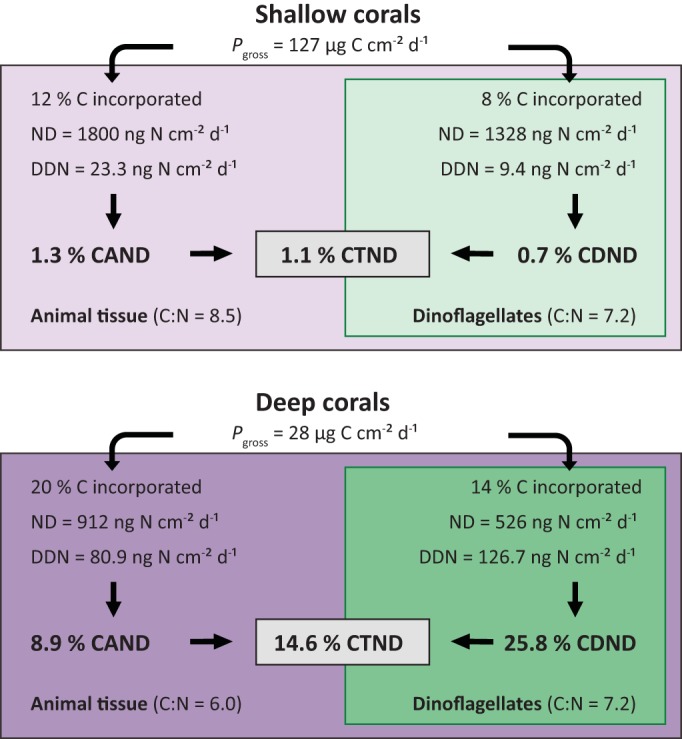
Overview of the percent contribution of DDN assimilation to the N demand (ND) of the animal host (CAND), the dinoflagellates (CDND), and the total symbiotic association (CTND) from shallow and deep S. pistillata corals. The ND was calculated from gross photosynthesis (Pgross) measurements (45), from values of C incorporation into the animal host and the dinoflagellates (48), and from C/N ratios (70) of S. pistillata corals at 5- and 50-m water depths in the Red Sea.